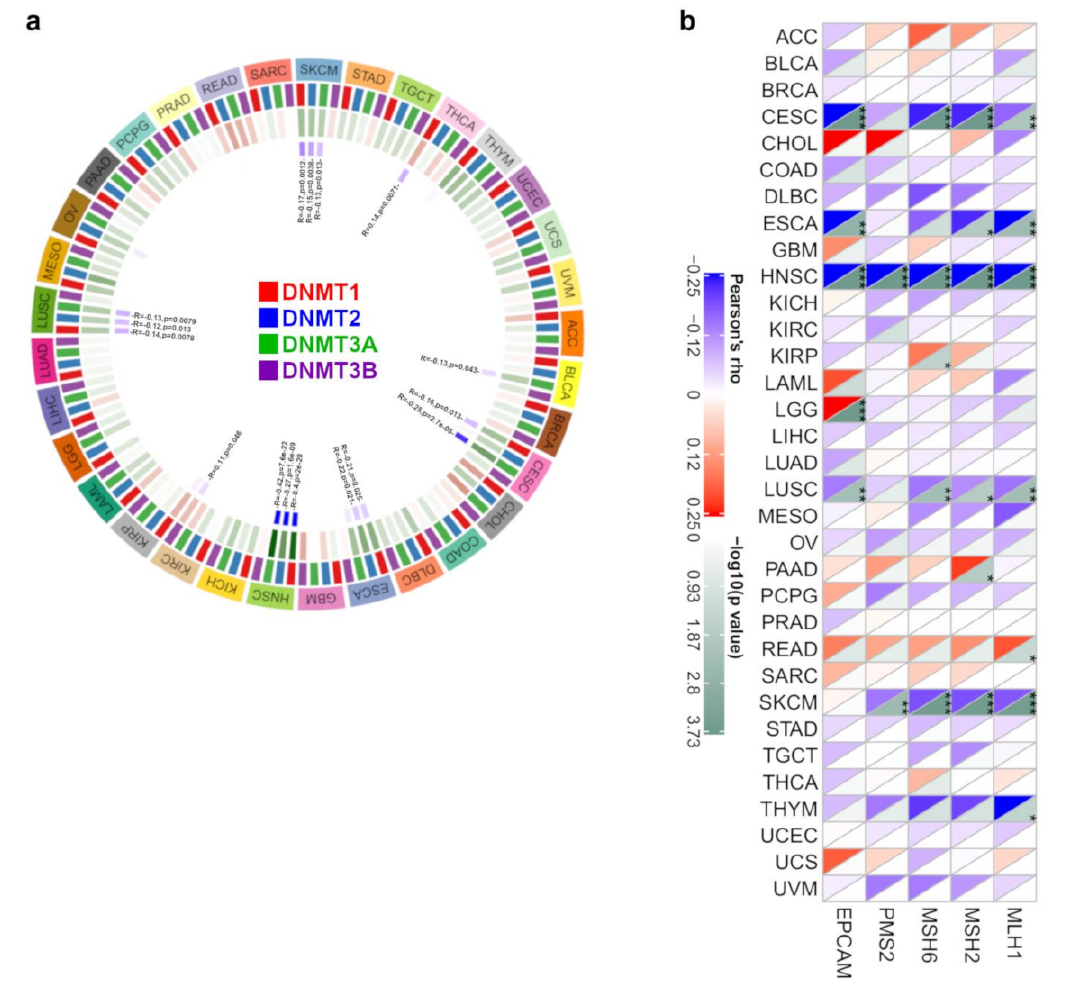
Figure 4. DNA methylation and mismatch repair analysis of S100A7 gene expression in different TCGA tumors. ( a ) The correlation between S100A7 gene level and the expression of four methyl- transferases (DNMT1, DNMT2, DNMT3A, DNMT3B) in different TCGA tumors. ( b ) The relationship between S100A7 gene expression and five MMR genes (MLH1, MSH2, MSH6, PMS2 and EPCAM) in different TCGA tumors. * p < 0.05; ** p < 0.01; *** p <